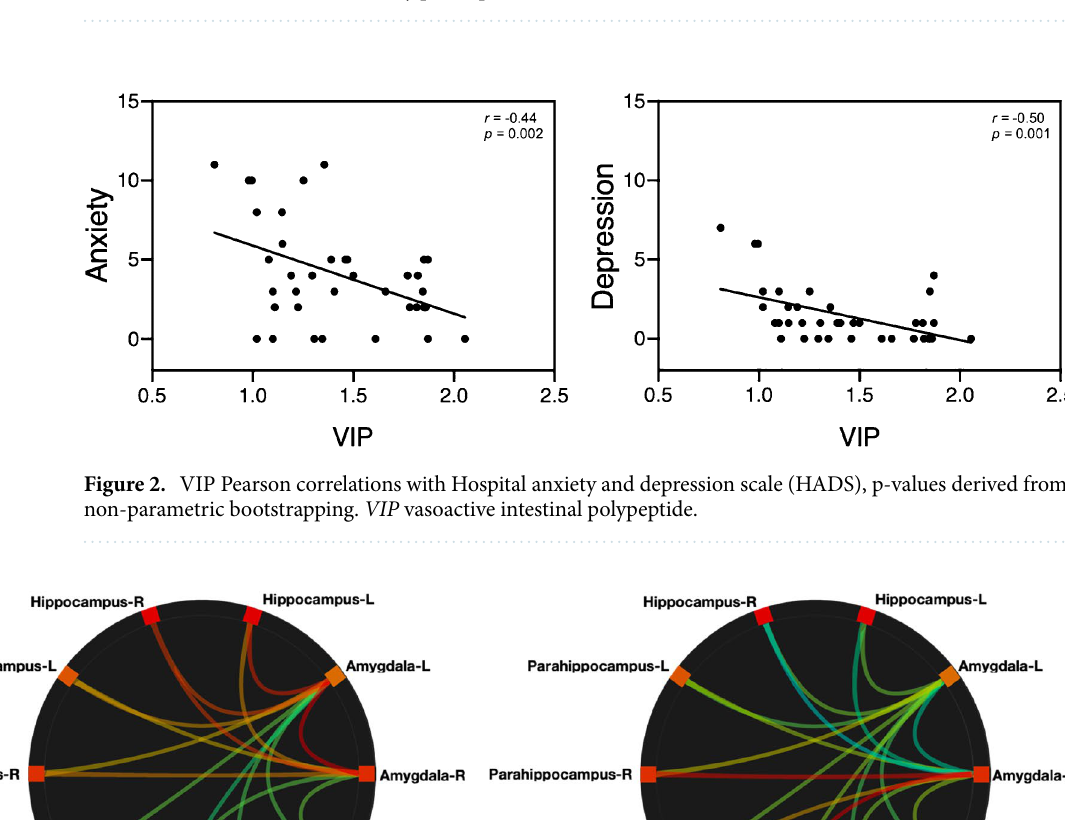
Table 1. Characterization of healthy participants.